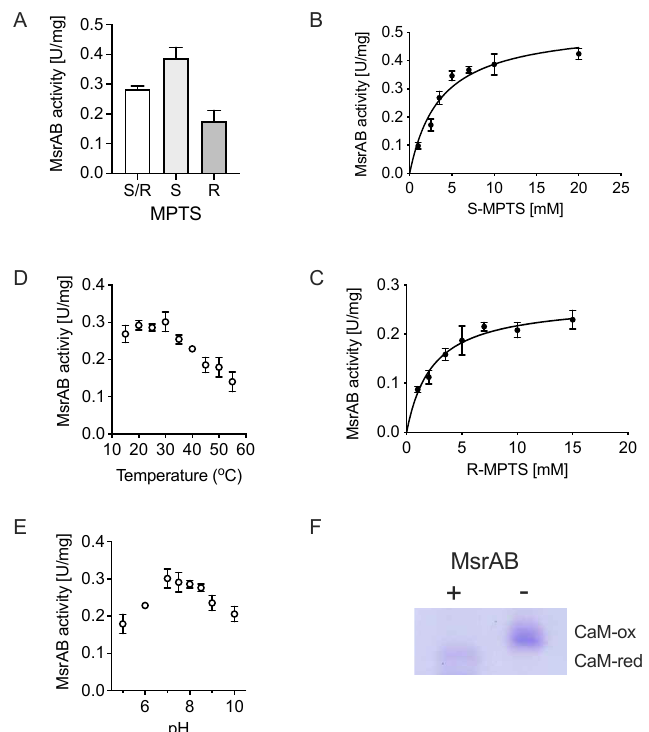
Figure 2. Catalytic activity of H. influenzae rMsrAB. ( A ): Stereospecificity of the rMsrAB reaction using R/S -, R - and S -Methyl-p-tolylsulfoxide (MPTS). ( B ): substrate concentration dependence of rMsrAB activity with S -MPTS. ( C ): substrate concentration dependence of rMsrAB activity with R -MPTS. Data was fit to the Michaelis–Menten Equation (see Table 3). ( D ): Temperature-dependence of rMsrAB activity. ( E ): pH-dependence of rMsrAB activity. ( F ): rMsrAB repair of oxidized calmodulin (CaM), ox—oxidized,